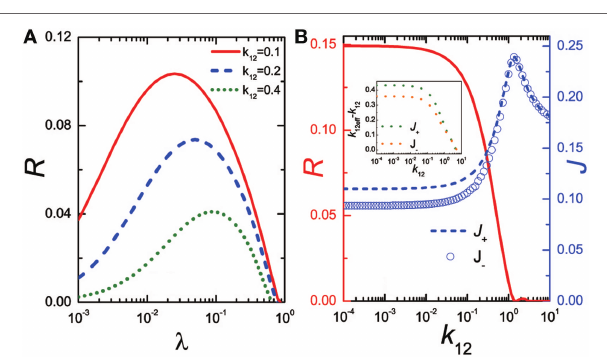
FIGURE 9 | (A) Interfacial thermal rectification R as a function of the interfacial nonlinearity λ . (B) Interfacial thermal rectification R as a function of the interfacial linear coupling k 12 . The inset in (B) shows the effective coupling from the nonlinearity k 12 ef (cid:0) k 12 as a function of the interfacial linear coupling k 12 . The figure has been adapted with permission from the copyright holder (Europhysics Letters), Zhang et al.